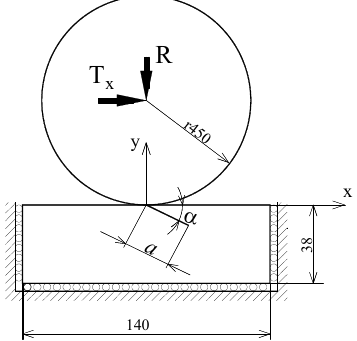
Figure 1: Scheme of the 2D model of a rail with the crack of together with the rail